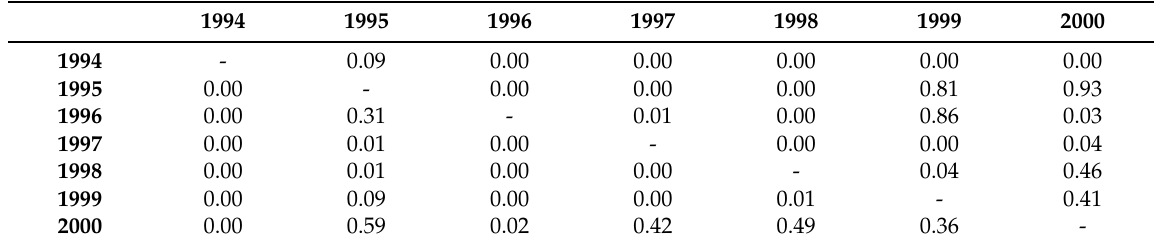
Table A4. Results of comparison tests of two ROC curves, one corresponding to the full model set (with both Wetness and Brightness slopes) and the other to the plain model set (with no remote sensing variable). p -values are shown. The ROC curve differs significantly for most